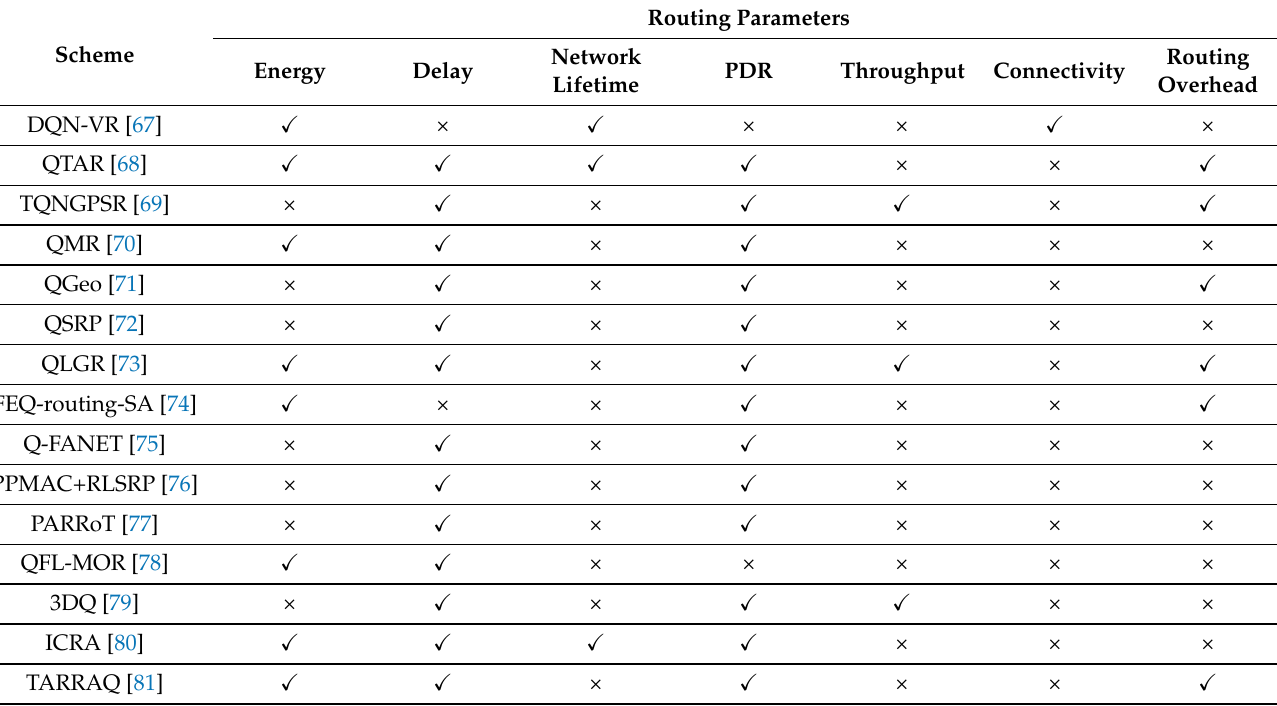
Table 25. Comparison of RL-based routing methods in terms of routing